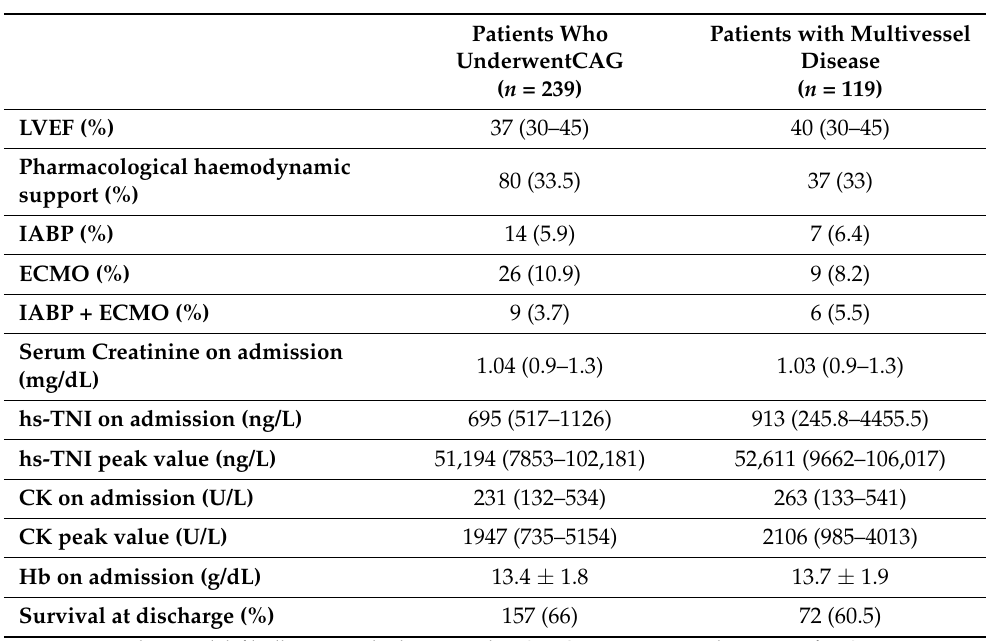
Table 2. Characteristics of the patients comparing complete vs. IRA-only revascularization.